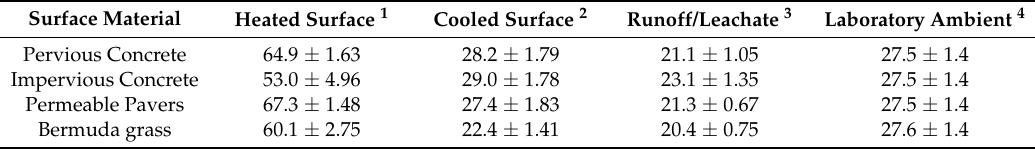
Table 1. Average steady-state temperatures, ◦ C, in the laboratory study using indoor heat lamps and simulated rainfall, Auburn University, Auburn, Alabama, 2018 ( n = 19